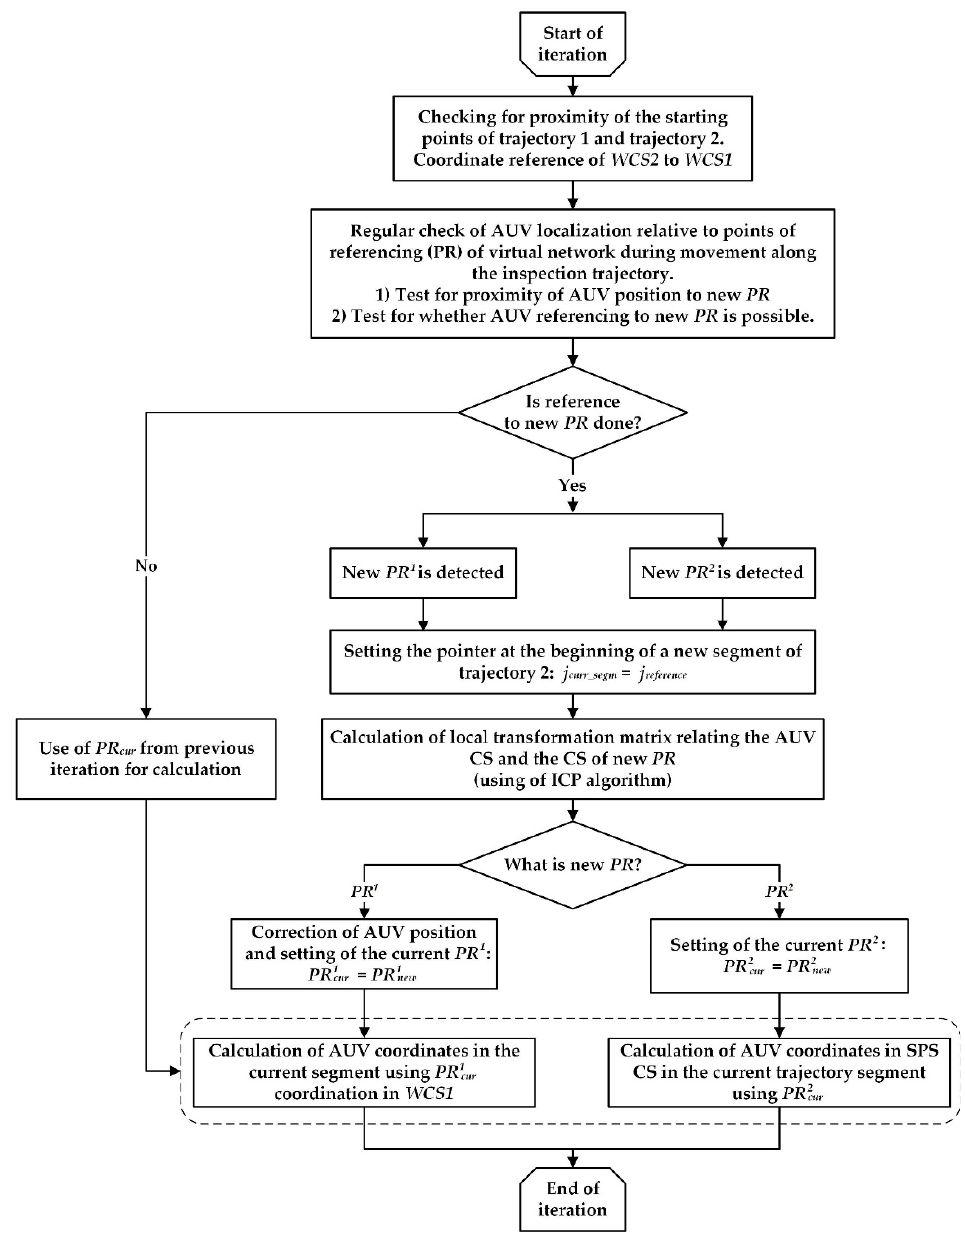
Figure 5. Flowchart of the algorithm for calculating the AUV coordinates in the SPS CS using the virtual network VCRN.